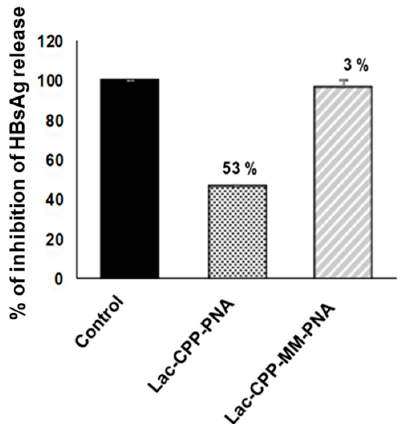
Figure 2. Antiviral effect of Lac(Lys)3-PNA conjugates in vitro , in HBV-infected cells. HepaRG, human hepatocyte like cells, were plated and infected with HBV followed by treatment with Lac(Lys)3-PNA (Lac-CPP-PNA) or with its corresponding mismatch control (Lac-CPP-MMPNA). The cell culture supernatants were harvested daily and Hepatitis B surface antigen (HBsAg) was quantified. Untreated HBV-infected control cells were considered as 100% and percentages of inhibition are indicated above the bars. The error bars display the standard deviation of duplicates.